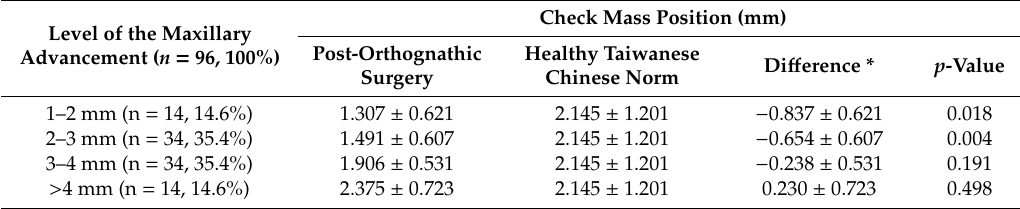
Table 6. Comparison of the check mass position between orthognathic surgery-treated patients and 3D healthy Taiwanese Chinese normative